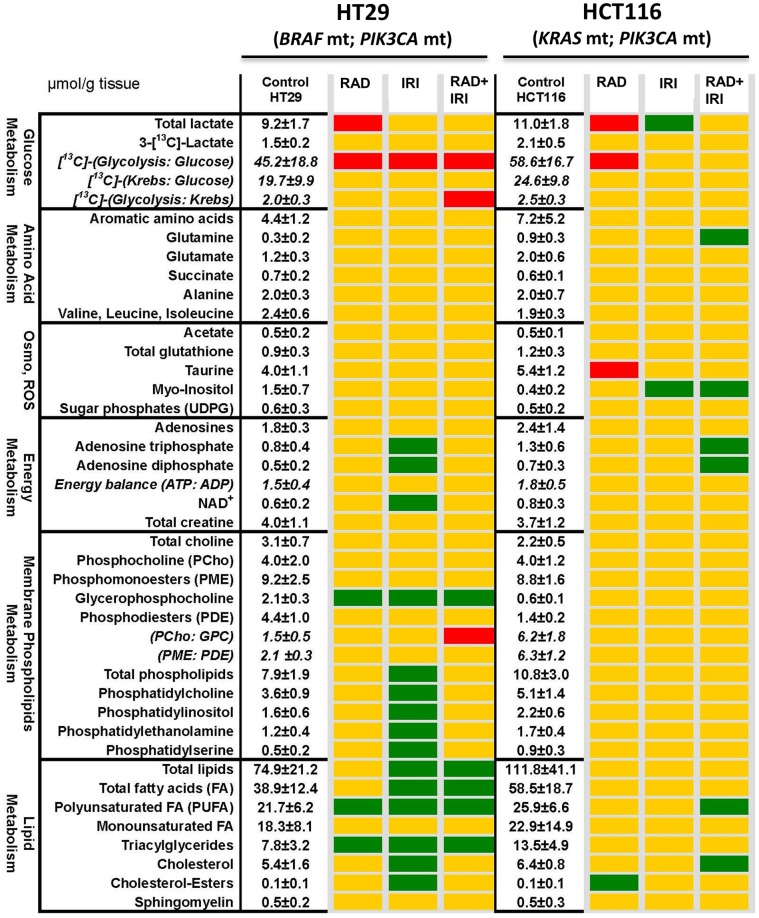
Metabolic heat-maps based on quantitative NMR spectroscopic data sets in HT29 and HCT116 xenografts at the end of the study.
1H-, 13C-, and 31P-NMR data are represented as mean ± SEM of 3–6 measurements. The metabolites, their ratios and metabolic fluxes were grouped based on their biochemical relevance. For the control group, all intracellular metabolite levels are given as µmol per gram cell wet weight and metabolite ratios are unitless. Metabolic pathways which were undisturbed by treatment are presented as yellow maps. A decrease in metabolic end-point is indicated by red, while an increase by green spots. Statistical significance for metabolite changes are based on multivariate analysis of metabolic fluxes with p<0.02. The interactive metabolic profile array database was custom-based [23].